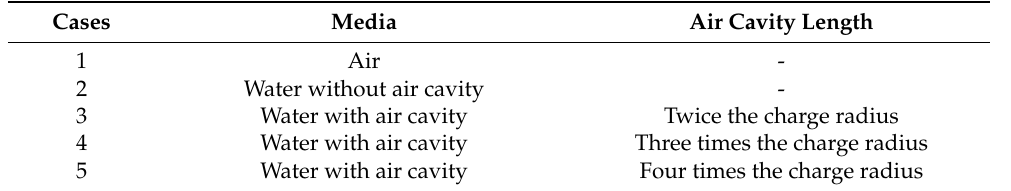
Figure 4. Numerical model of the underwater explosion of a shaped charge with air cavity. Table 3. Cases for different numerical models.